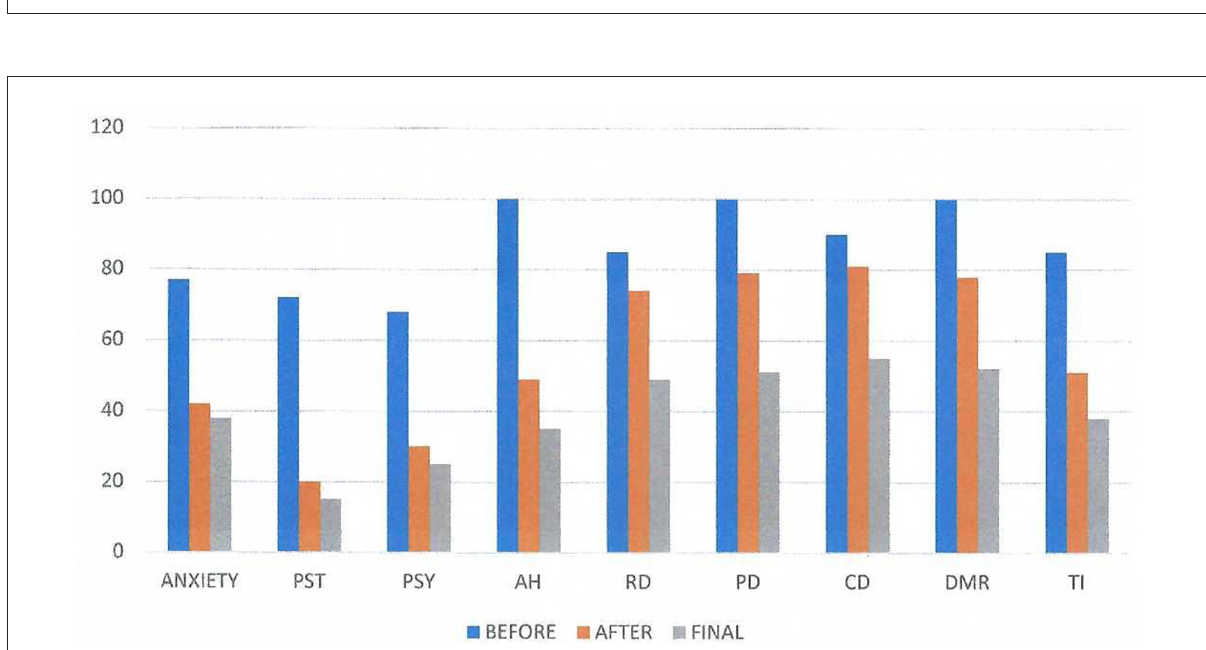
FIGURE3 Visual Analog Results on three conditions: before and after the first neurofeedback session and the results of the final session. The abbreviation PST represents the general psychological state of the subject, PSY the psychosomatic symptoms, AH the auditory hallucinations, RD the delusions of reference, PD the persecutory delusions, CD the delusions of being controlled by outside forces, DMR the delusions of mind reading, and TI the thought insertion. The self-assessment scale had a length of 10cm, where “O” represented “I have no such symptom” and “I00” represented “The symptom is extremely annoying”. We evaluated the mean scores. We observe great significance in the scales AH, PST, Anxiety, DMR, and